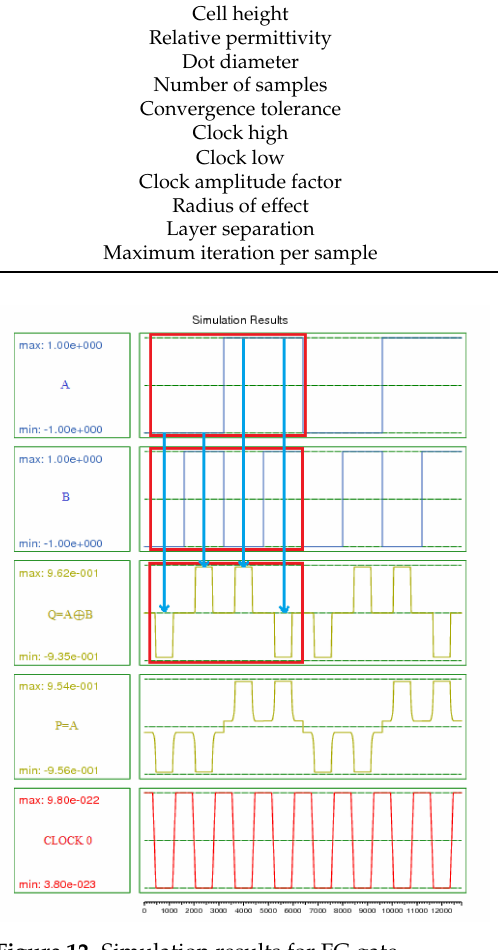
Figure 12. Simulation results for FG